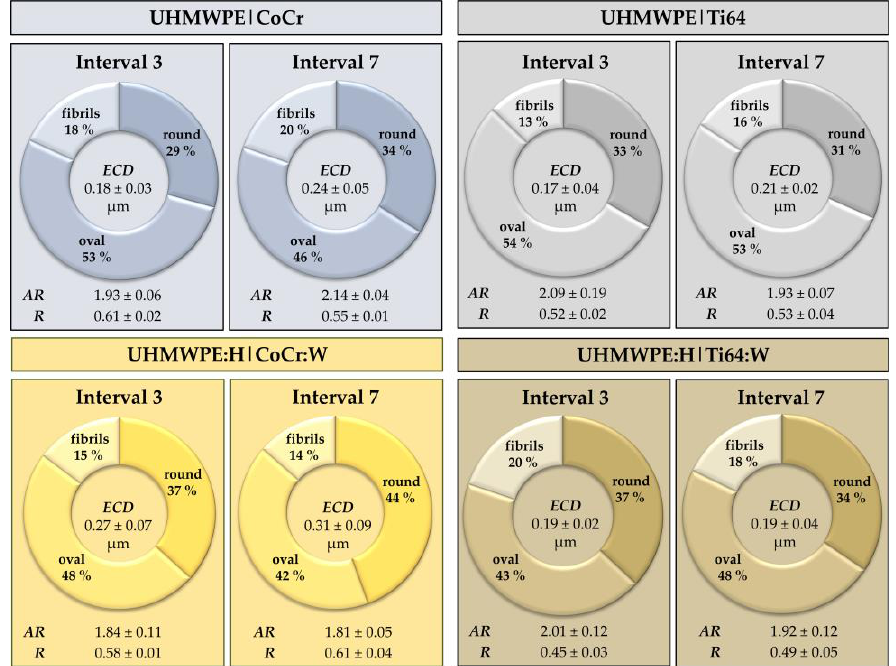
Figure 14. Mean values and standard deviations of ECD , AR and R as well as the portions of round, oval and fibril-like particles for the four pairings at two analyzed intervals (3 and 7) of the tribometer